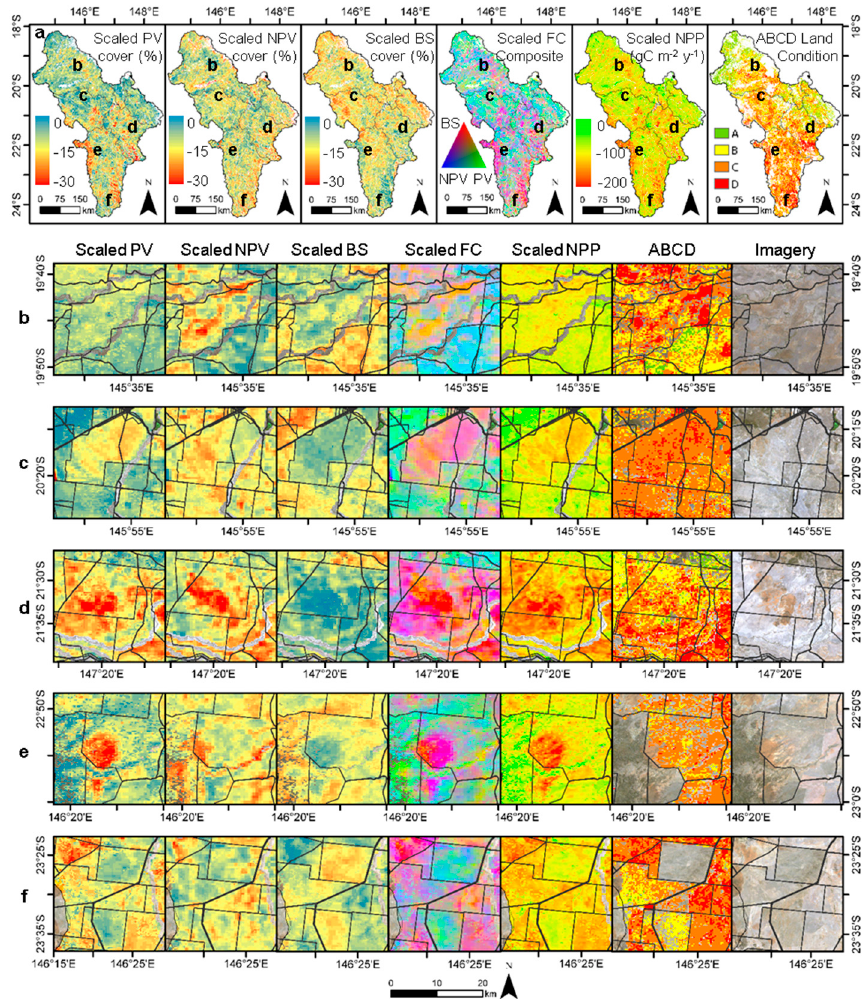
Figure 3. Comparison of the individual scaled components of fractional cover averaged from 2000 to 2013 ( a ) for the entire BDT from November to April showing, scaled photosynthetic vegetation (PV), scaled non-photosynthetic vegetation (NPV), scaled bare soil (BS) cover, a composite of scaled fractional cover components, scaled NPP, and Karfs et al. [43]’s ABCD land condition assessment from with ( b ) fine scale comparisons of the five locations shown in ( a ) and a true color composite of Landsat imagery. Grey lines in ( a ) are basin boundaries and in ( b – f ) are property boundaries.